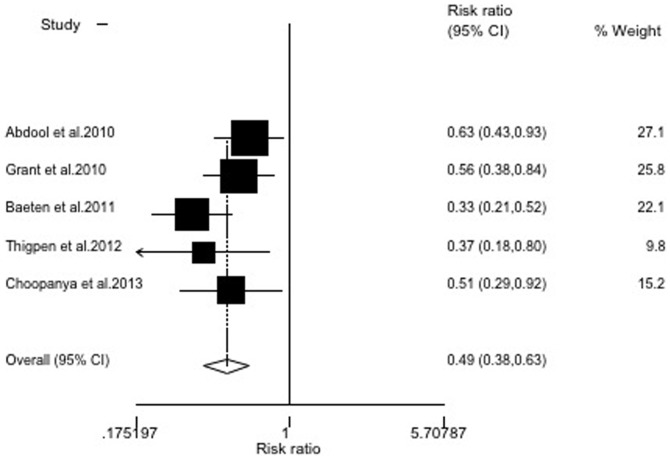
Random-effects model meta-analysis, excluding two studies with no statistical significance.Heterogeneity chi-squared = 5.58(d.f. = 4), P = 0.233; test of RR = 1∶z = 5.51, P<0.001.